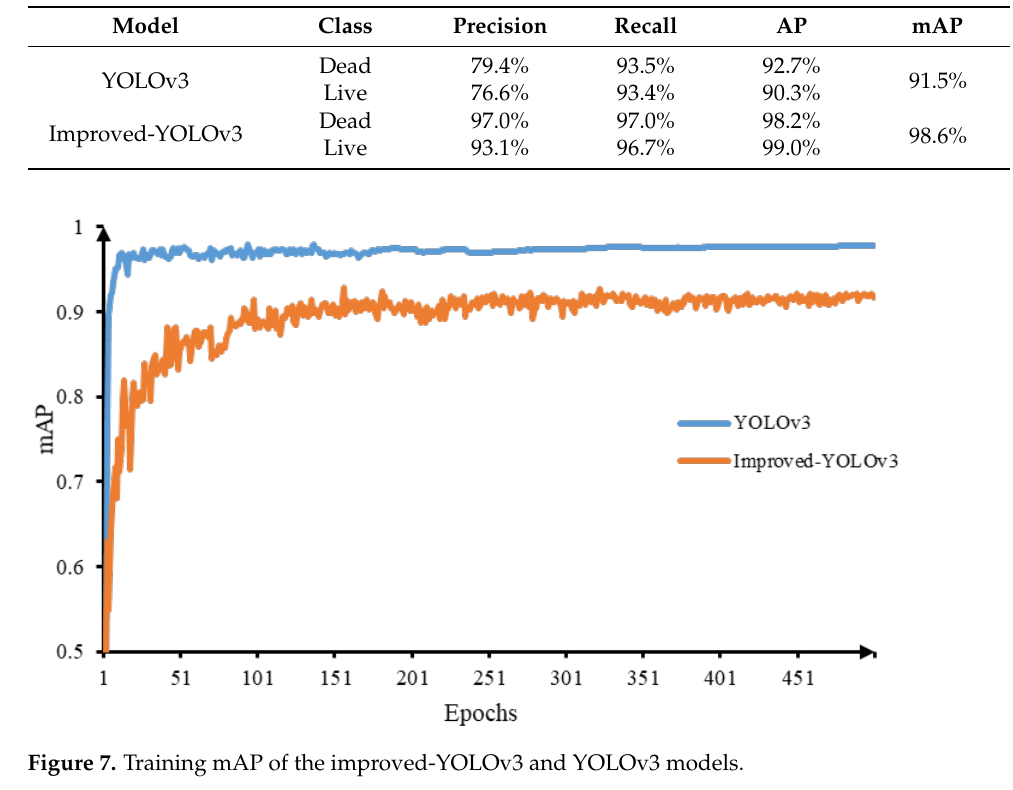
Table 4. Comparison of the detection models.